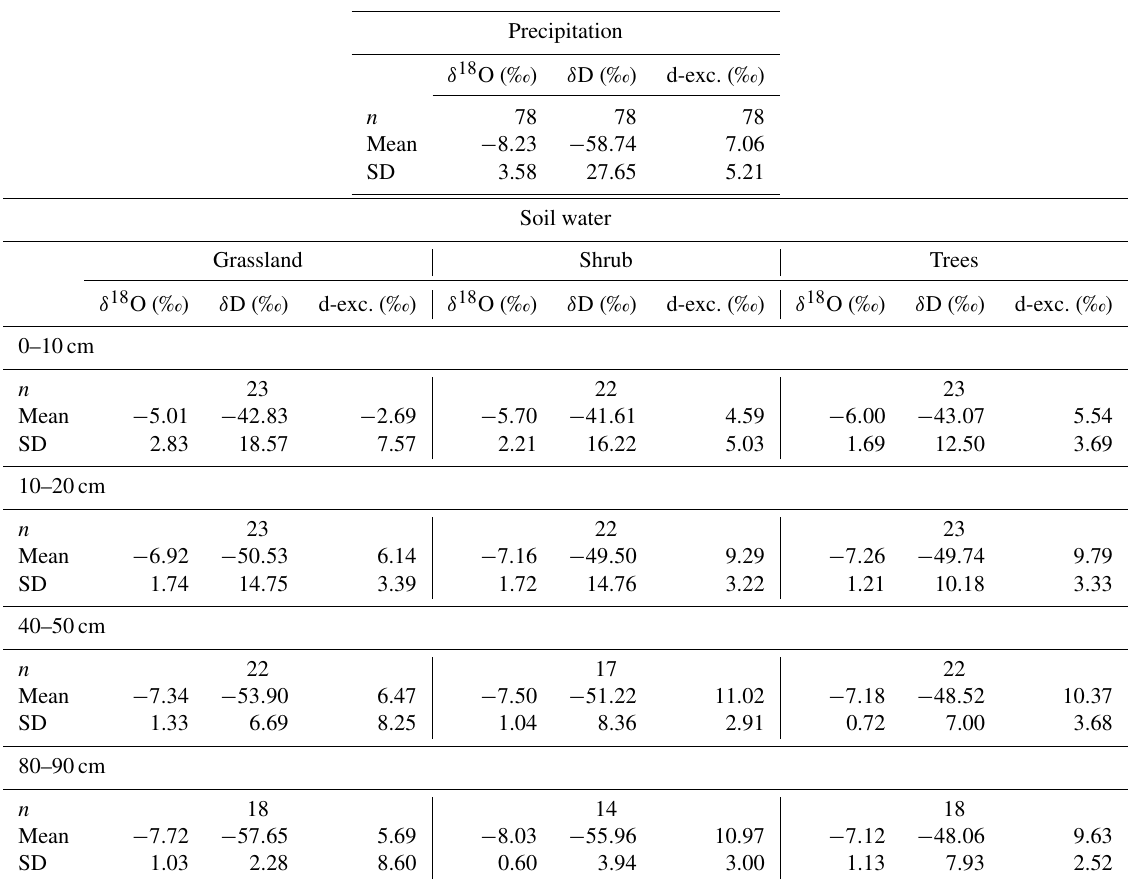
Table 6. Number of samples ( n ) with measured isotopic composition of P and soil water under the three soil-vegetation units for different sampling depths.